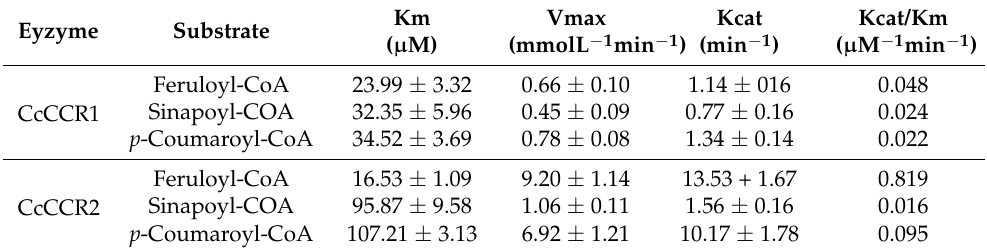
Table 2. Kinetic parameters of CcCCR1 and CcCCR2.